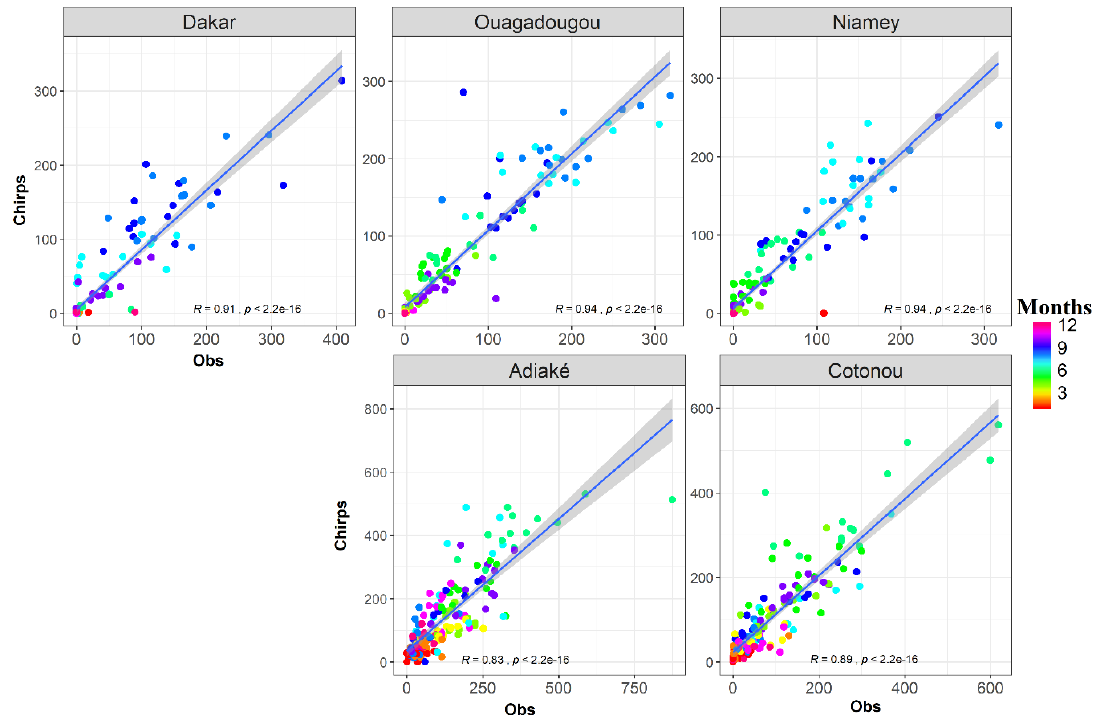
Figure 2. Comparison of monthly rain gauge stations and the corresponding nearest grid points in the Climate Hazards Group InfraRed Precipitation with Station (CHIRPS) dataset for the considered five stations. Each colored dot represents a month, and the gray shaded area around the line represents the 95% confidence interval around the regression line .